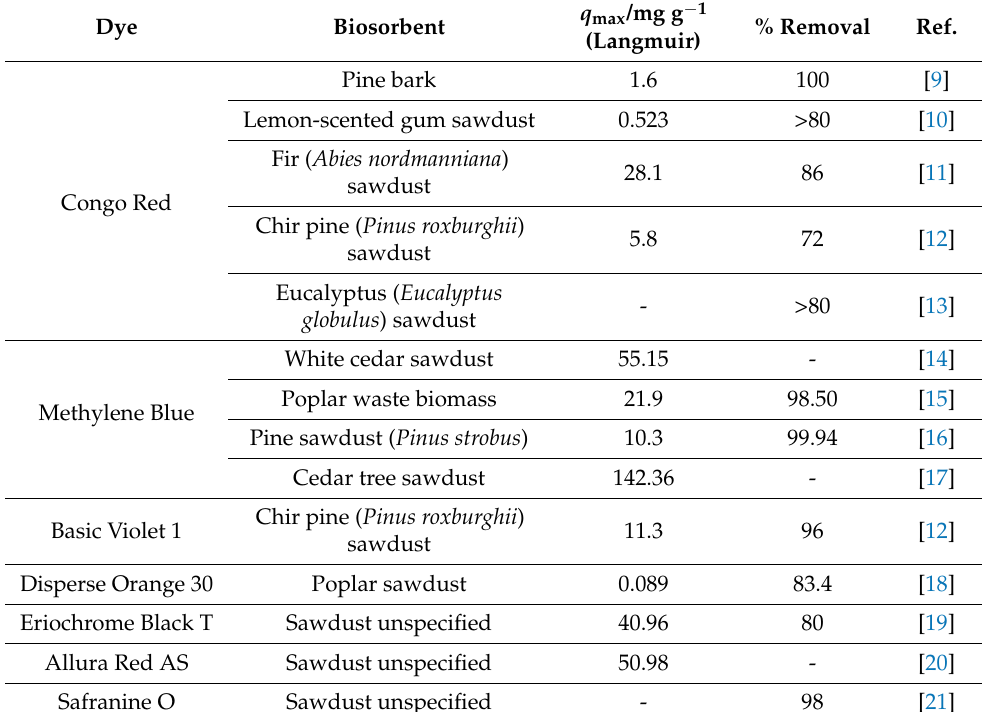
Table 1. Removal of synthetic dyes using waste wood biomass as biosorbent.